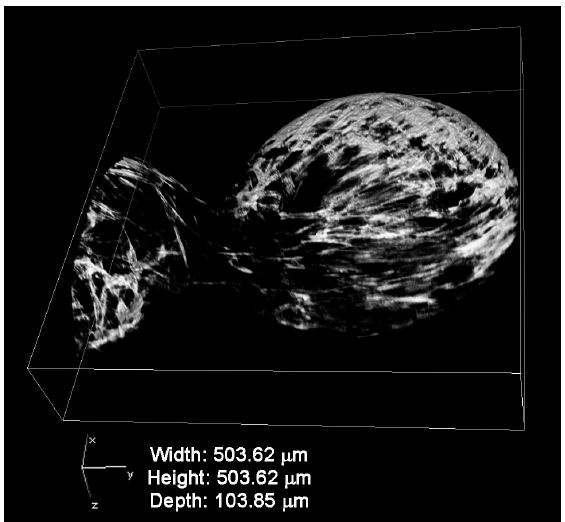
Figure 6. Confocal microscopy image of human adipose derived stem cells (hASCs) F-actin cytoskeleton distribution on FAM surface after 7 days from cell seeding.